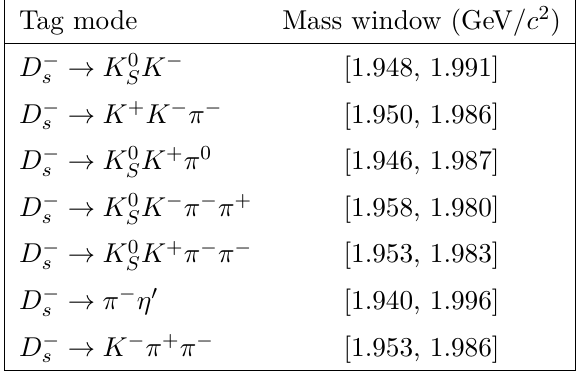
Table 2 . Requirements on M tag for various tag